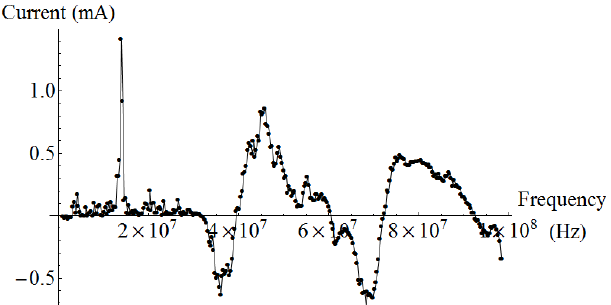
Figure 9: Effects induced by random positions of conductors in the electrical raceways (factor 1) on the mean end-current magnitude ( a ) 1, µ